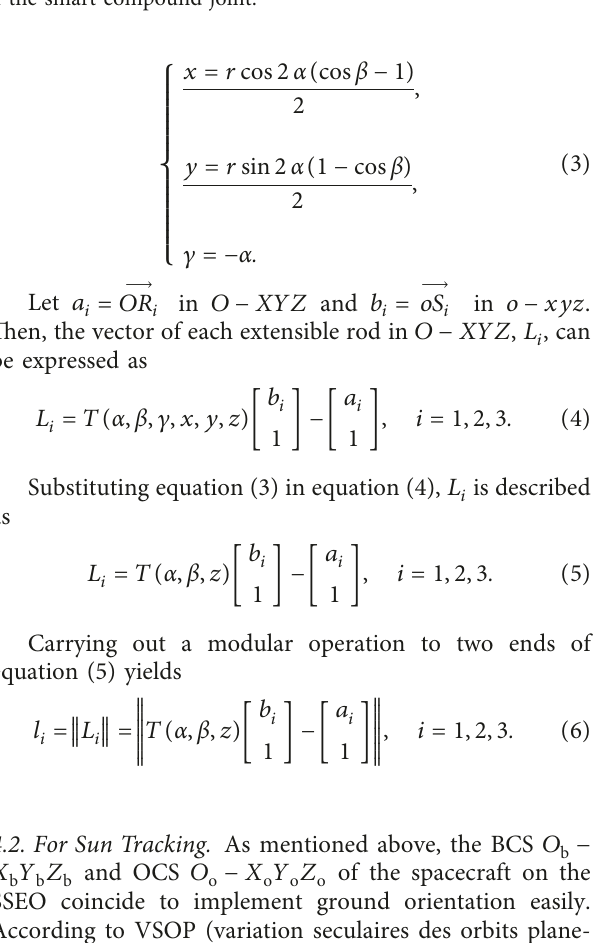
Figure 9: An exploded diagram of the smart compound joint.